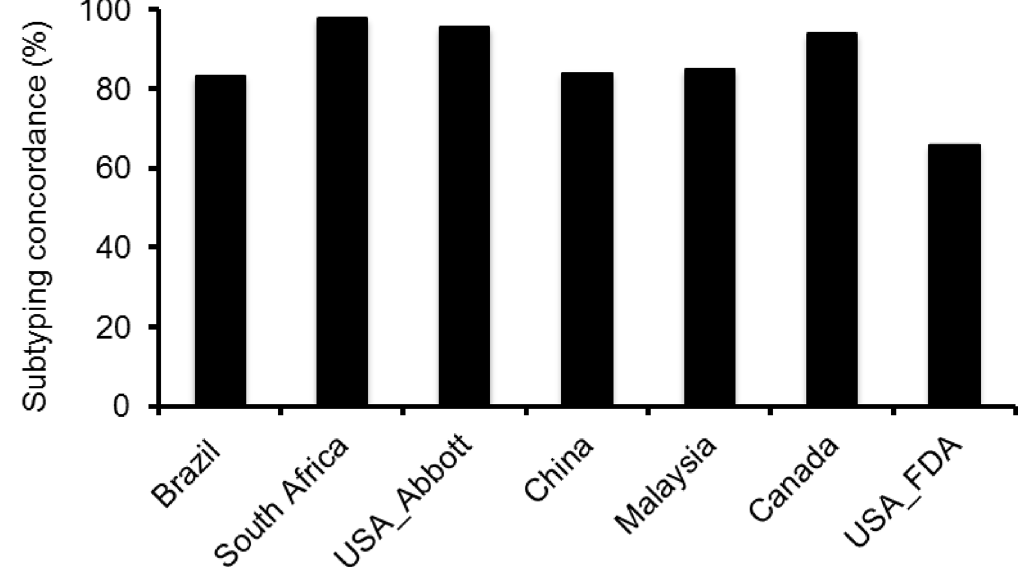
Fig 2. Comparison of subtype results across all sites. The subtype results from each site were compared to those determined by analyzing the 47 group M whole genome sequences at EQAPOL.